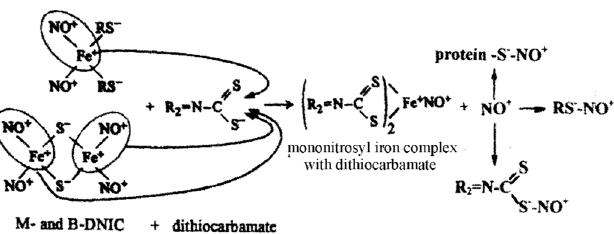
Scheme 2. The mechanism of the conversion of B- and M-DNIC with thiol-containing ligands into MNIC with dithiocarbamate ligands. Released NO + cations can S-nitrosylate low-molecular and protein-bound thiol groups or dithiocarbamate derivatives [93]. (With permission).